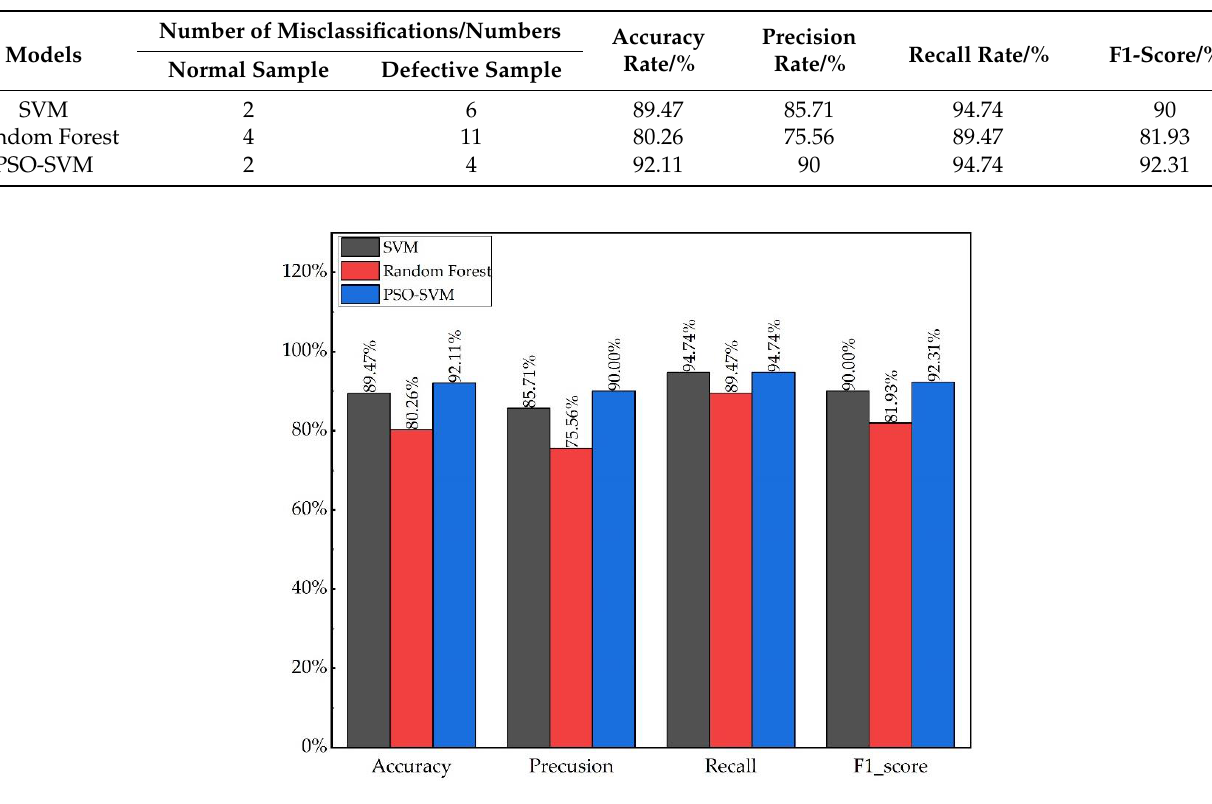
Figure 11. Comparison of classification performance between PSO-SVM and other models.